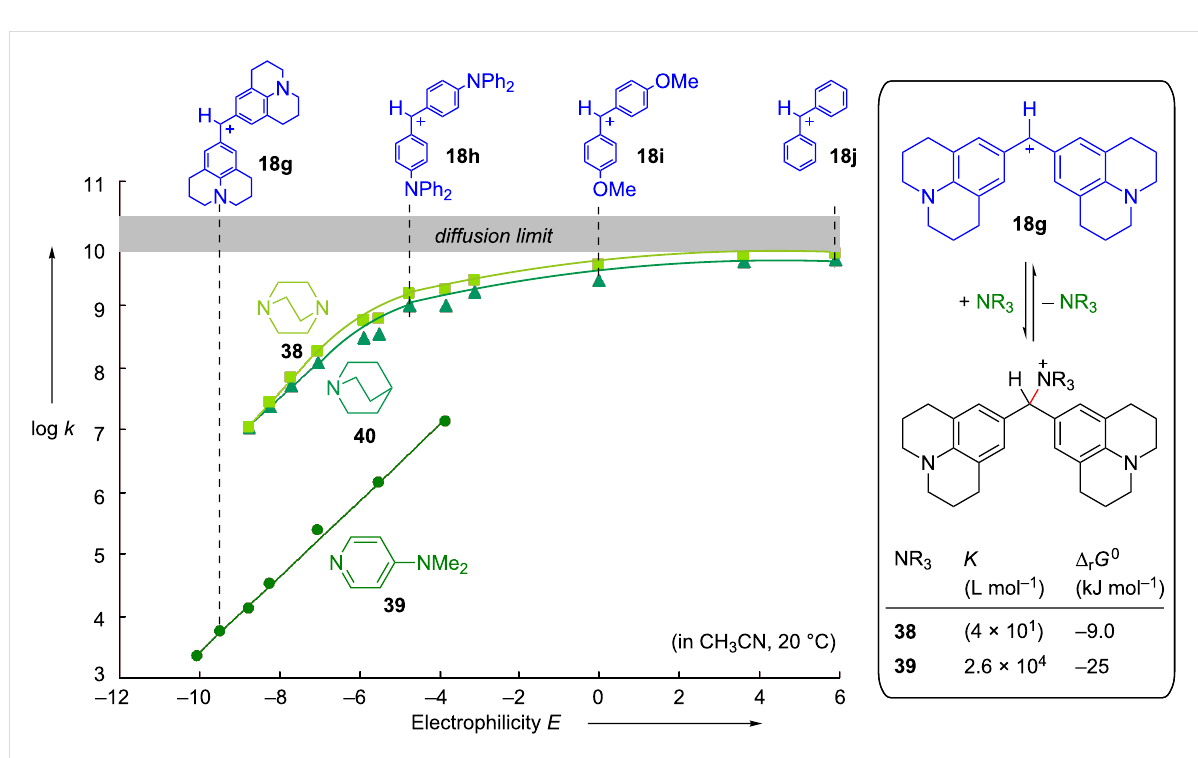
Figure 22: Differentiation of nucleophilicity and Lewis basicity (in acetonitrile at 20 °C): Rate (left) and equilibrium constants (right) for the reactions of amines with benzhydrylium ions